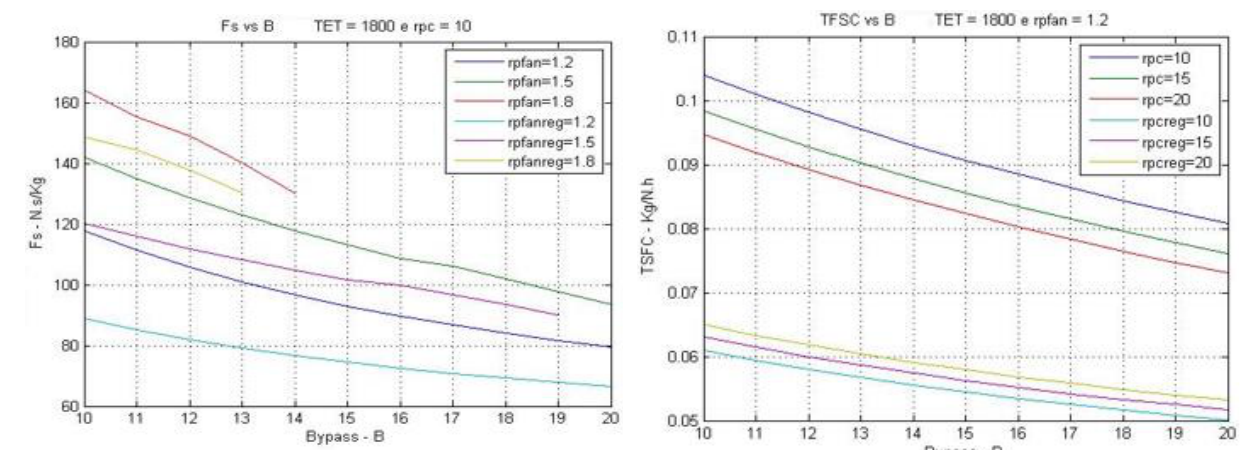
Figure 7: TSFC vs BPR with and without regeneration (TET 1800K and rpfan 1.2).